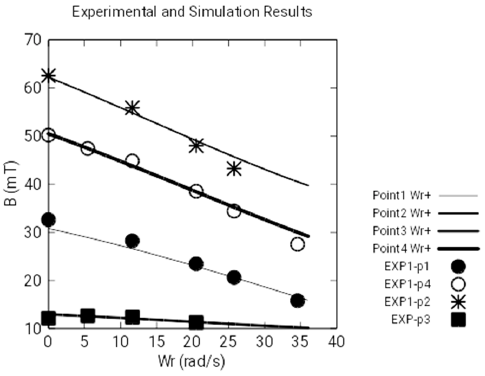
Figure 9. Measurement of the magnetic field with clockwise Wr – .